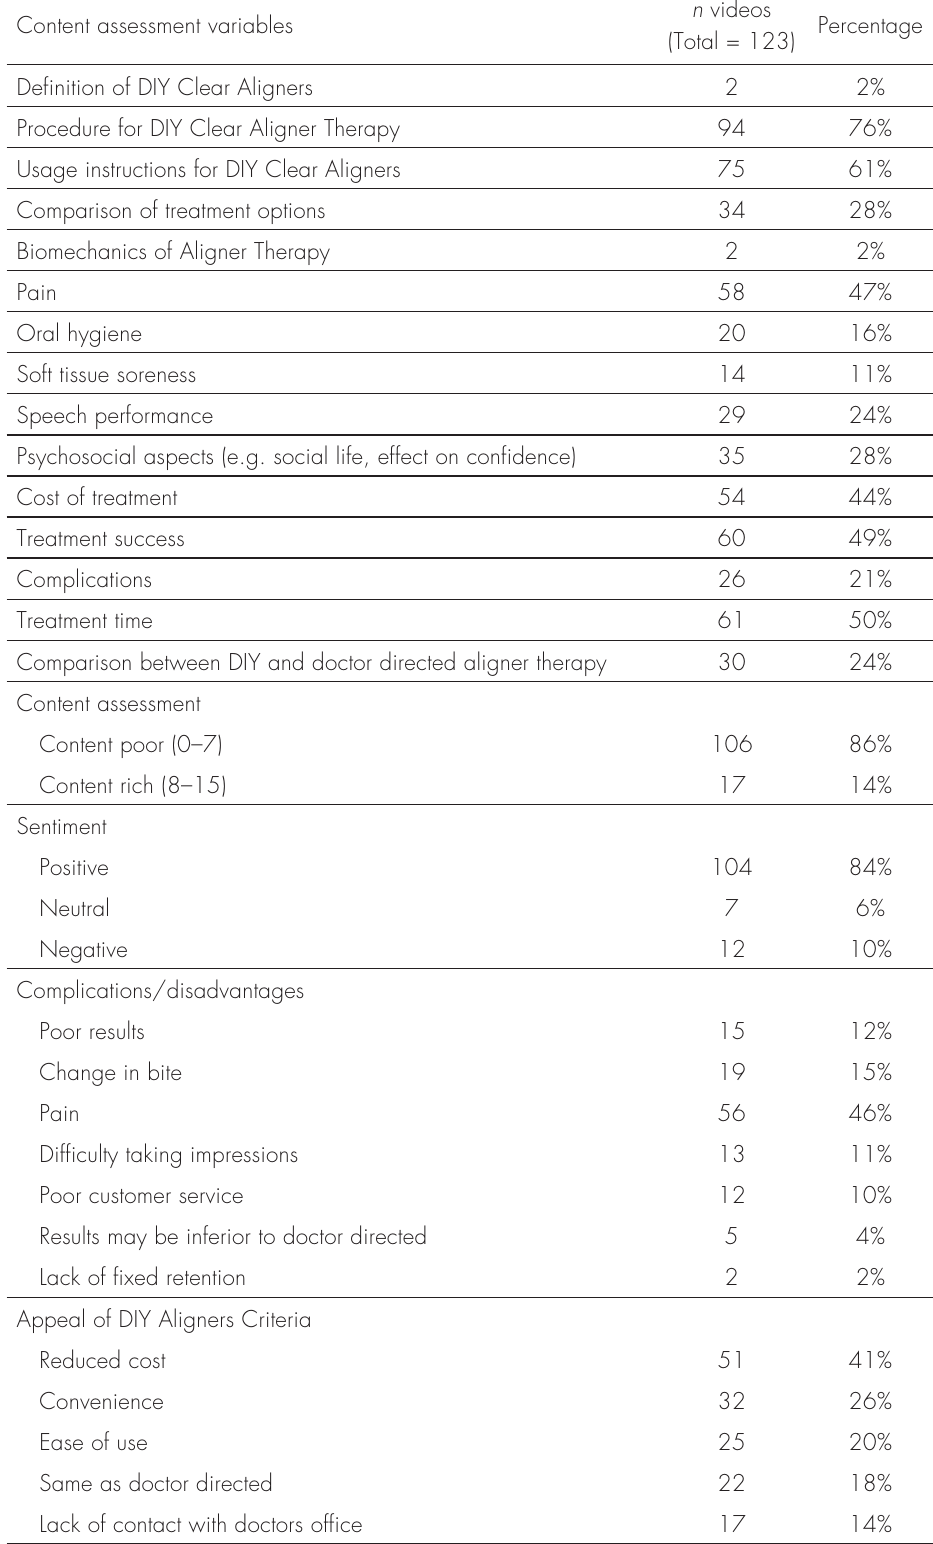
Table VI. Descriptive statistics of content assessment. The cumulative results from each video assessment are expressed as the number (n) of videos or as a percentage of the total number of videos Content assessment